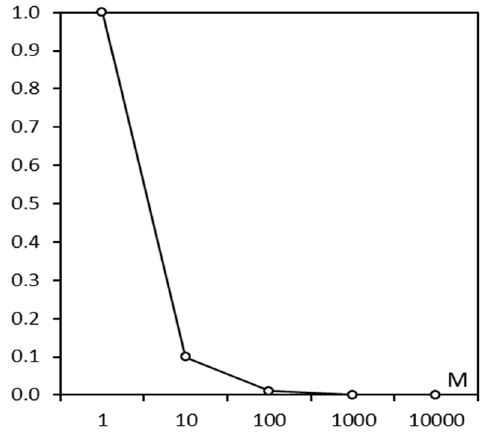
Figure 7. The download time rate of videos decreases as the data size increases.